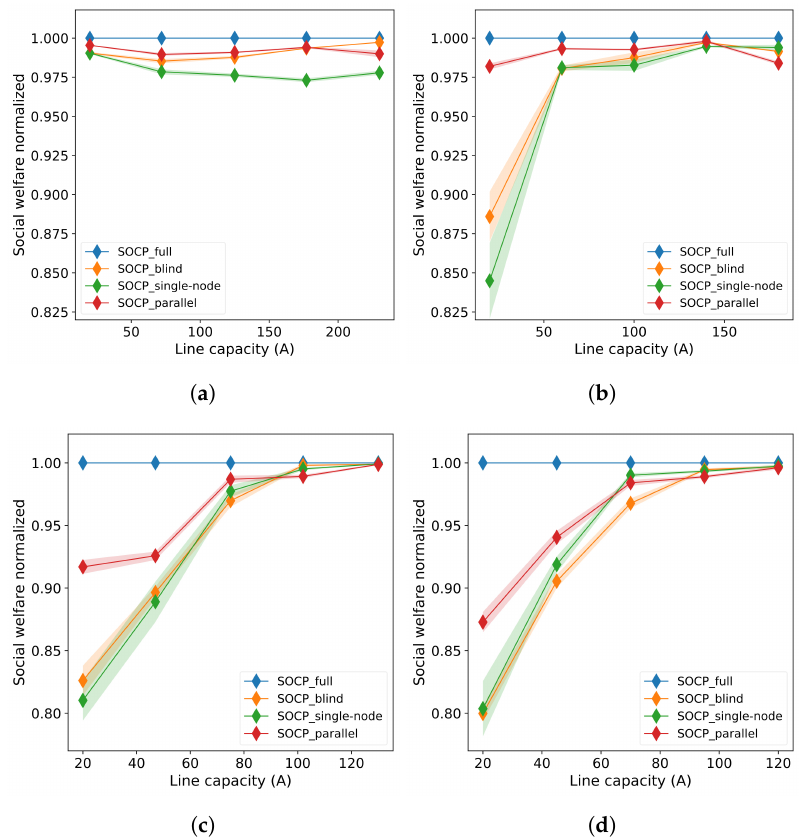
Figure 7. Social welfare provided the surrogate models, full and blind planners. Values are normalized relative to the full planner. Horizontal axis is the lines current limit. ( a ) Radial grid with single generator. ( b ) Radial grid with DGs. ( c ) Meshed grid with DGs between cables. ( d ) Meshed grid with DGs between and at